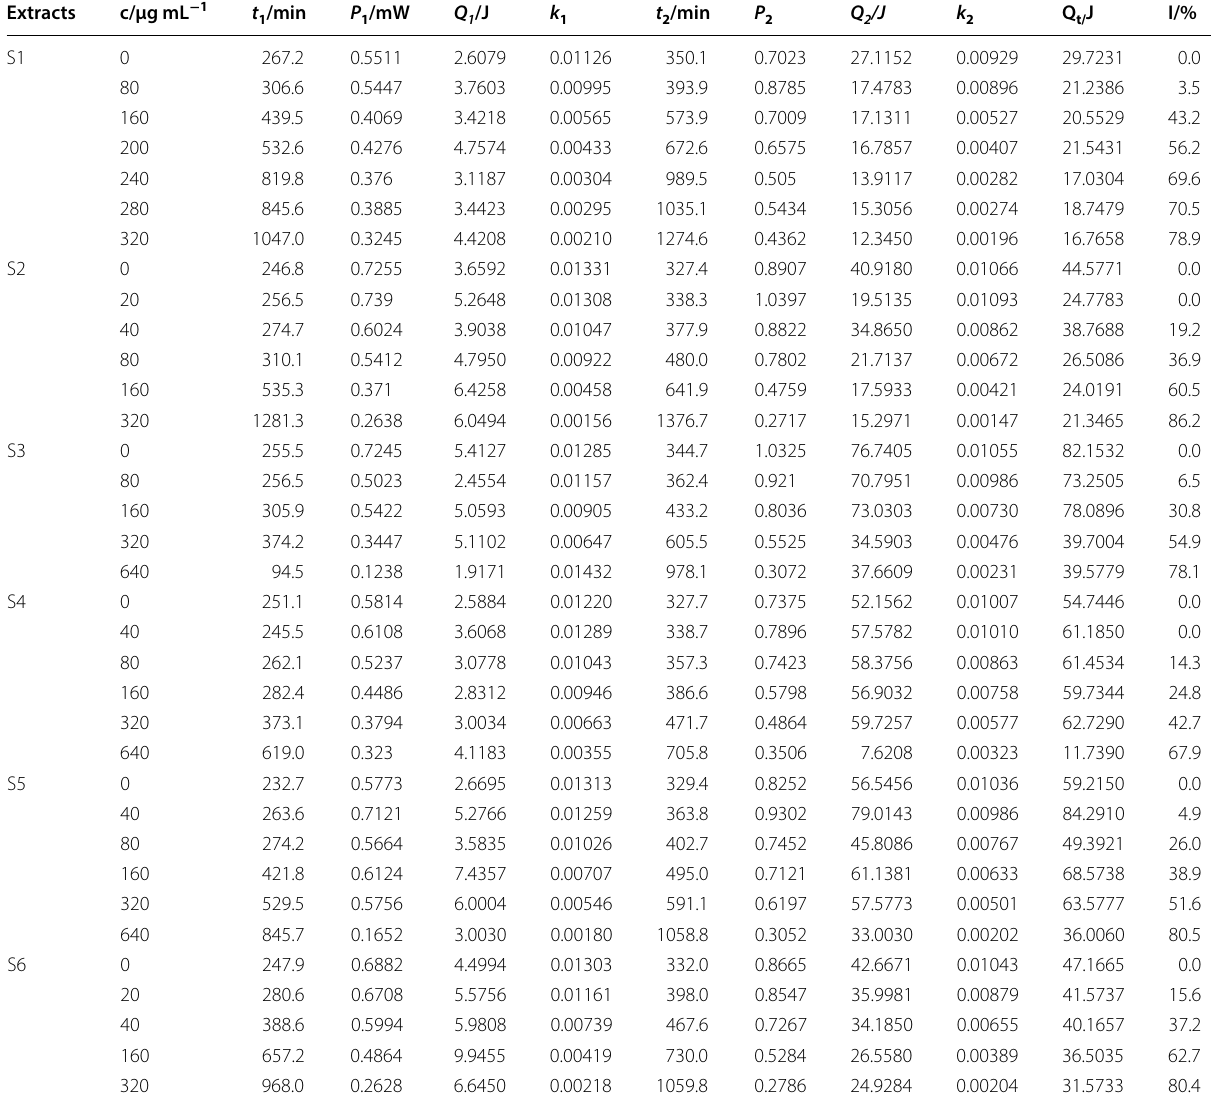
Table 1 Thermokinetic parameters of ampicillin‑resistant E. coli growth in the presence of six samples from the leaves of Dracontomelon dao Extracts c/μg mL −